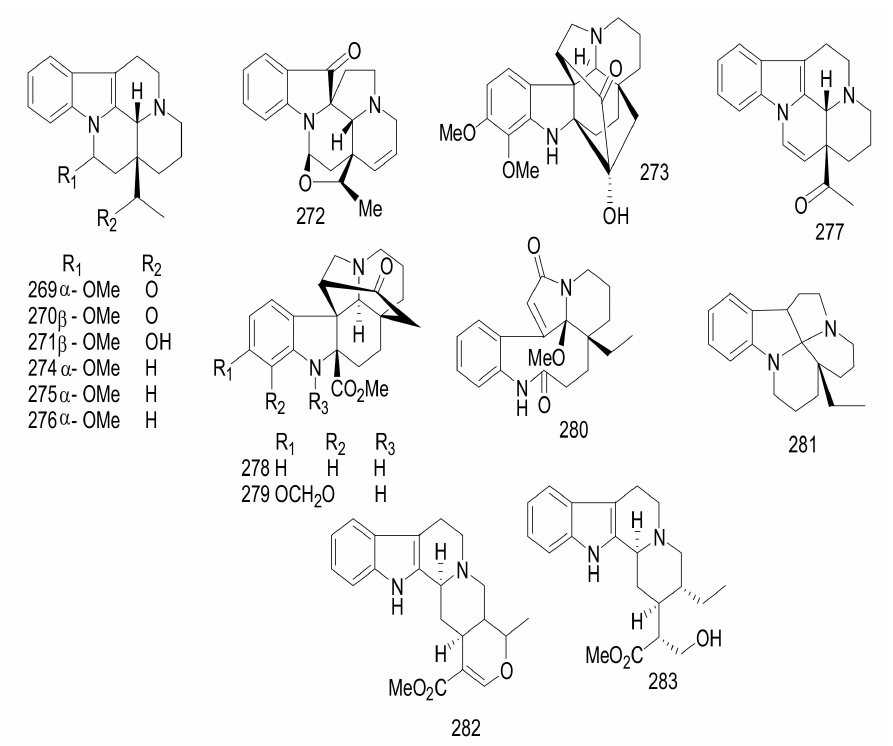
Figure 23. Compounds 269 – 283